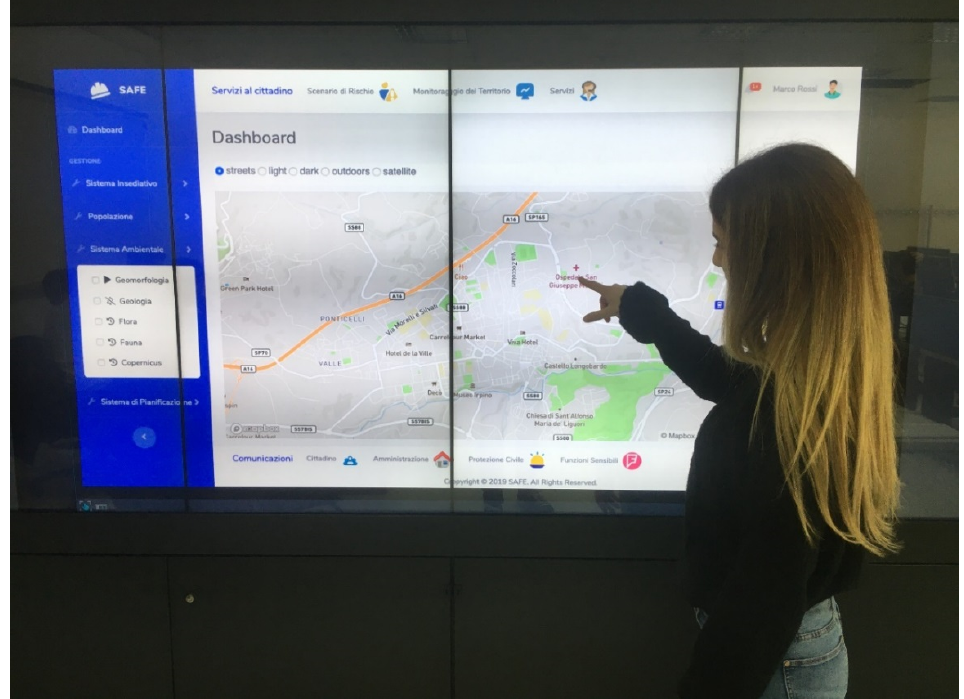
Figure 25. The SAFE visual environment at LabGIS.